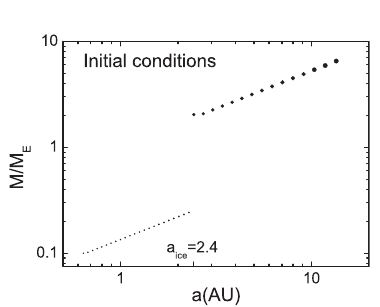
Figure 1. A sketch map of the initial conditions in our simulations, mars-size planets extend from 0.5 2.4AU, while earth-size planets extend to 10 AU.